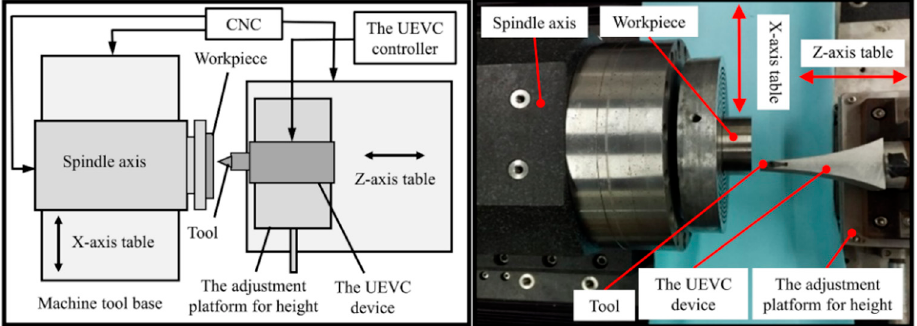
Figure 3. Diagram and picture of experimental setup.